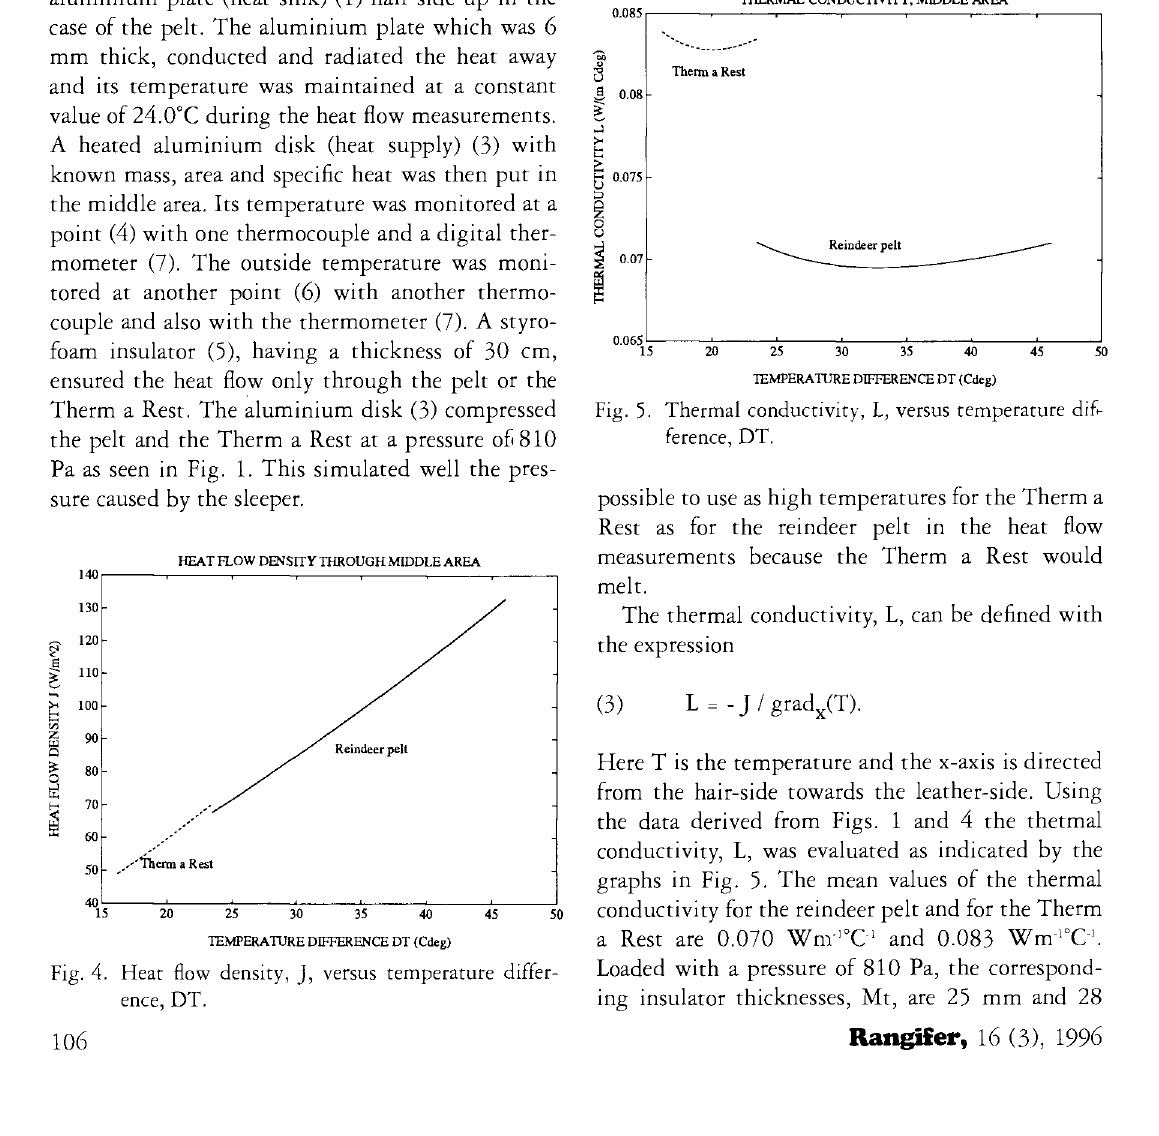
Fig. 3- Arrangement in hear flow and thermal conducti vity experiments. 1 aluminium plate as heat sink, 2 reindeer pelt hair-side up or Therm a Resr, 3 aluminium disk as heat supply, 4 and 6 thermo couples, 5 styrofoam insulator and 7 digital ther mometer.